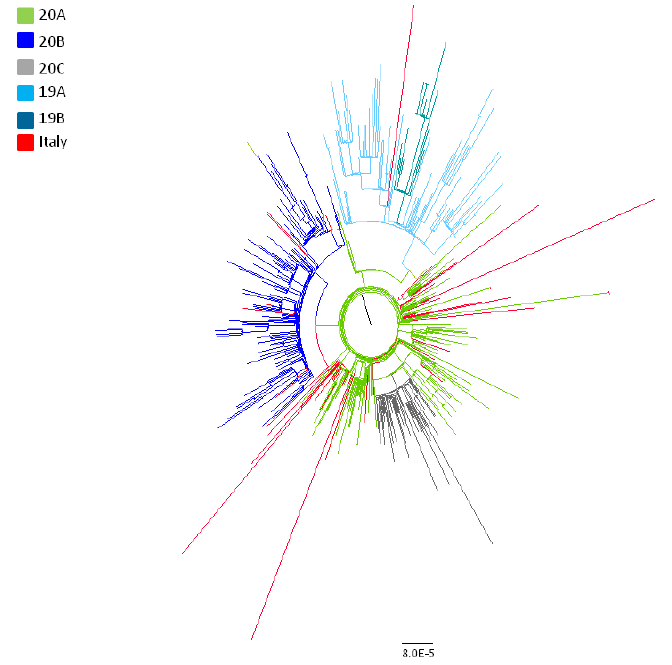
Figure 1. Maximum likelihood tree of the full dataset including 588 SARS-CoV-2 genomes. Nextstrain classification is indicated by colors as reported in the legend. Italian strains are highlighted in red.